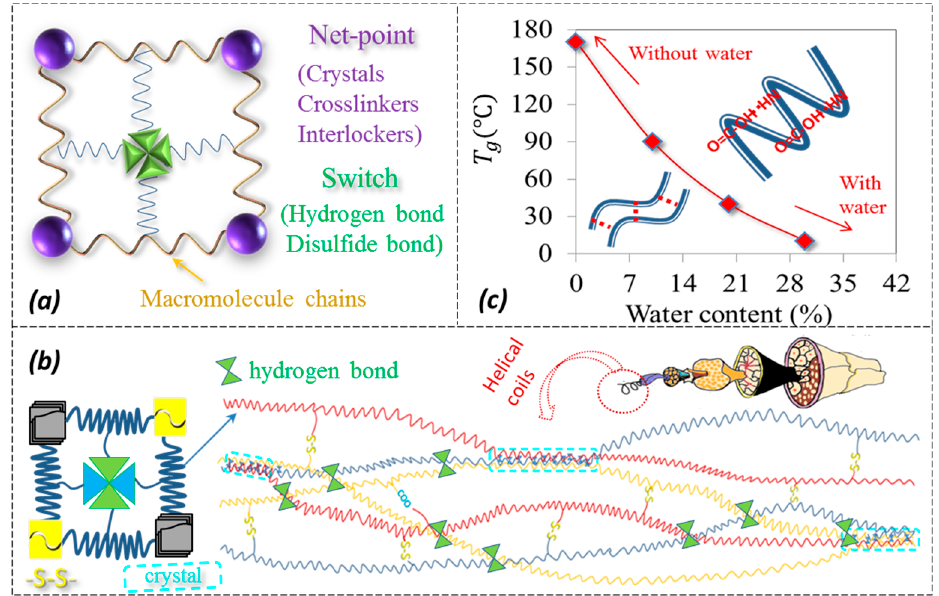
Figure 1. Schematic illustrations of ( a ) a typical netpoint-switch model for shape memory polymers (SMPs) in which candidates for netpoint may be crystals, chemical crosslinkers, or interlockers and for switches may be hydrogen bonds (HBs) or reversible covalent bonds; ( b ) a structural model for α -keratin fiber with discrete crystalline phase linked by α -keratin backbones embedded in an amorphous matrix that contains HBs, disulfide bonds, and salt linkages; the inset shows a twin-netpoint-single-switch model for α -keratin fiber; ( c ) the relationship of wool’s glass transition temperature ( T g ) and the water content for which the inset shows the HBs at intra- and inter-molecule chains for the cause of T g variation with and without water molecules.